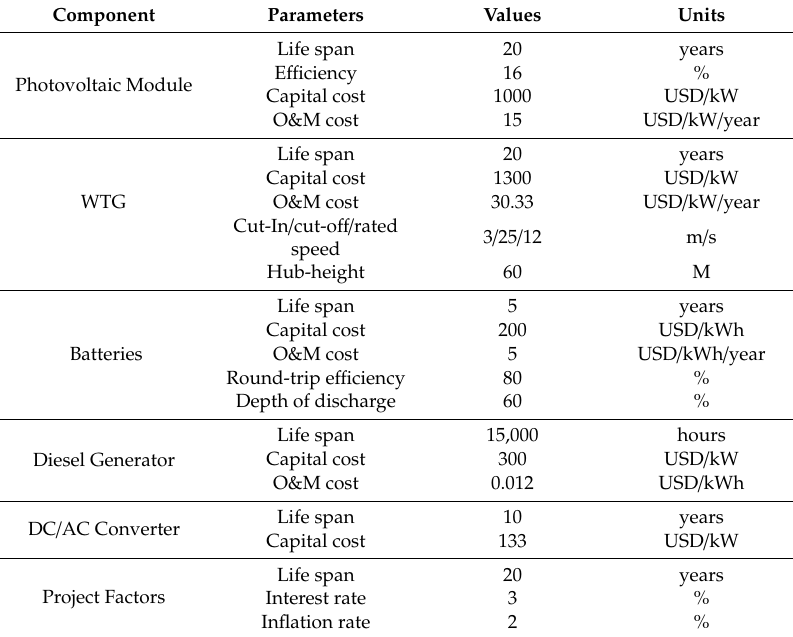
Table 2. Technical and economic parameters of the HES